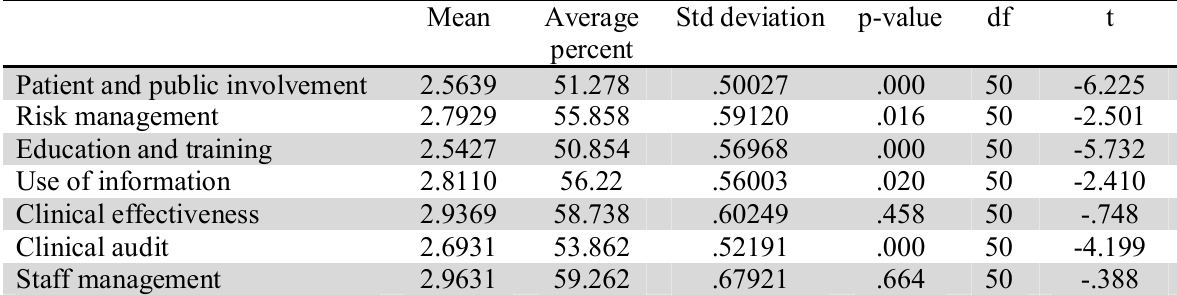
Clinical governance pillars